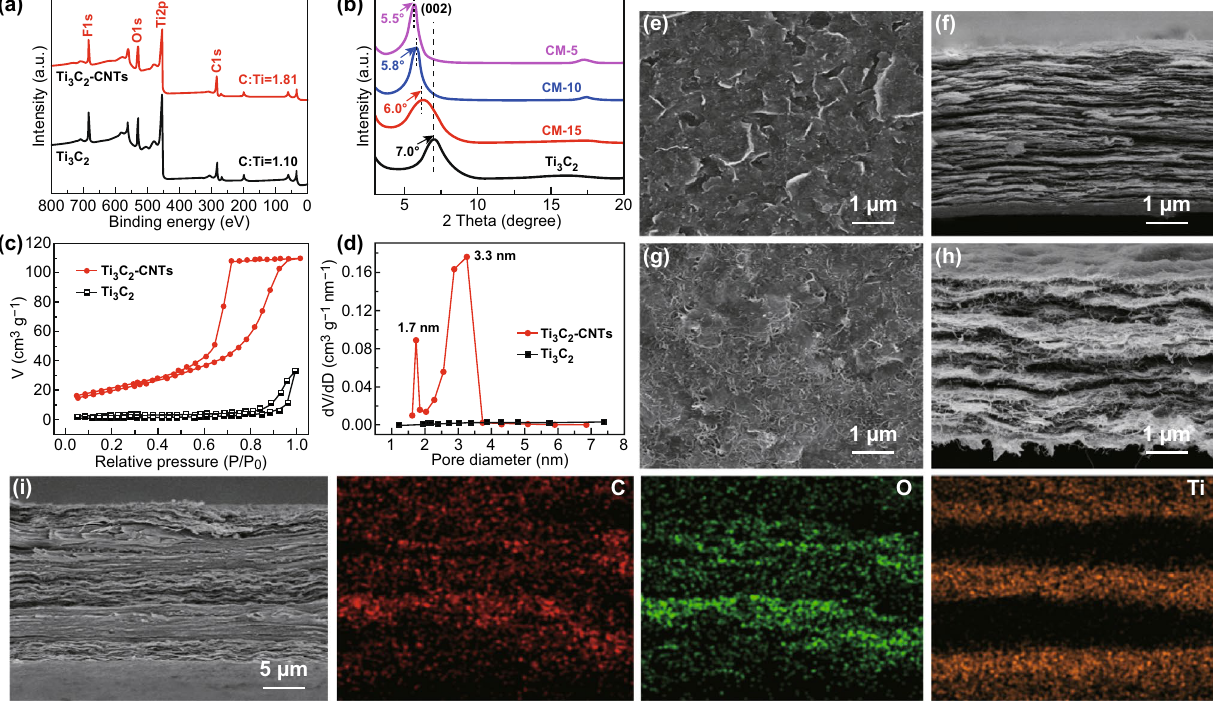
Fig. 2 a XPS survey spectrum of the pure Ti 3 C 2 paper and Ti 3 C 2 –CNTs composite paper. b XRD patterns of the Ti 3 C 2 –CNTs composite paper with different Ti 3 C 2 contents. c , d N 2 sorption/desorption isotherms and pore size distribution curves of pure Ti 3 C 2 paper and Ti 3 C 2 –CNTs com‑ posite paper. e Top‑view and f cross‑sectional SEM images of pure Ti 3 C 2 paper. g Top‑view and h cross‑sectional SEM images of Ti 3 C 2 –CNTs composite paper. i Cross‑sectional SEM and EDS mapping images of CMC GS composite